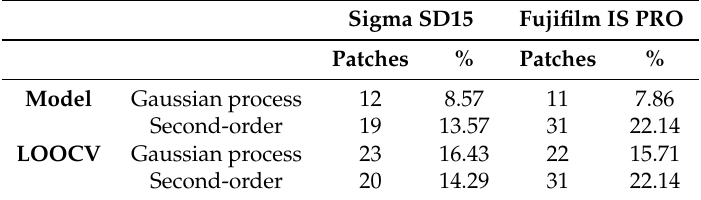
Table 3. Percentage of patches with LOOCV ∆ E ∗